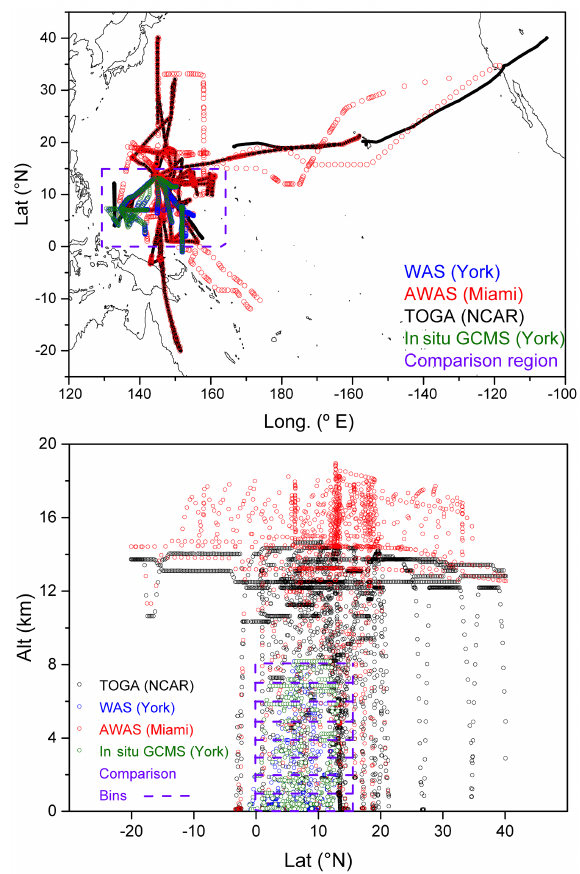
Figure 1. Top: spatial distribution of all CAST, CONTRAST and ATTREX VSLS measurements, coloured according to instru- ment: WAS (blue), AWAS (red), TOGA (black) and in situ GCMS (green). Box (purple dashes) depicts region chosen for sample inter-comparison. Bottom: vertical distribution of all CAST, CON- TRAST and ATTREX VSLS measurements, coloured according to instrument as per Fig. 1. Purple dashed boxes show individual com- parison bins (see Sect.